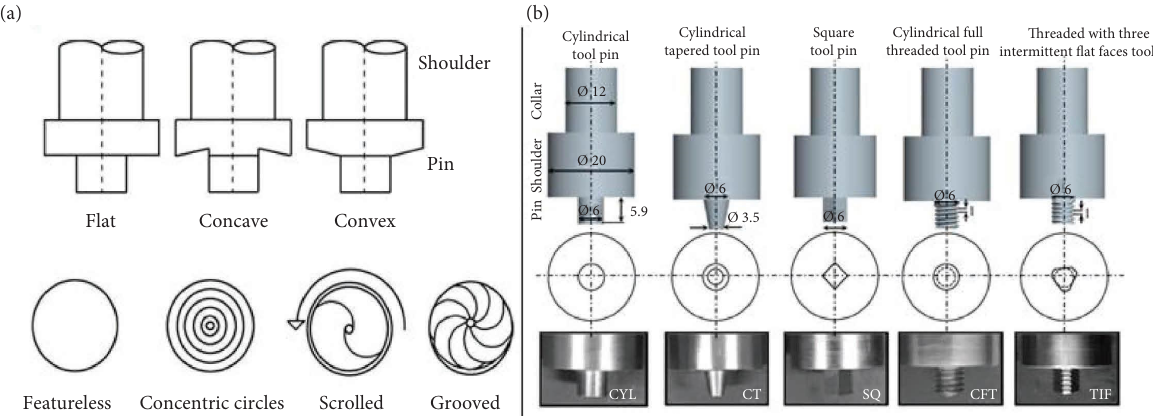
Figure 5: Diferent tool designs profles used in FSW process. (a) Shoulder designs [55], (b) tool pin profles (CYL-cylindrical, CT- cylindrical tapered, SQ-square, CFT-cylindrical full threaded, TIF-threaded with three incremental fat faces)